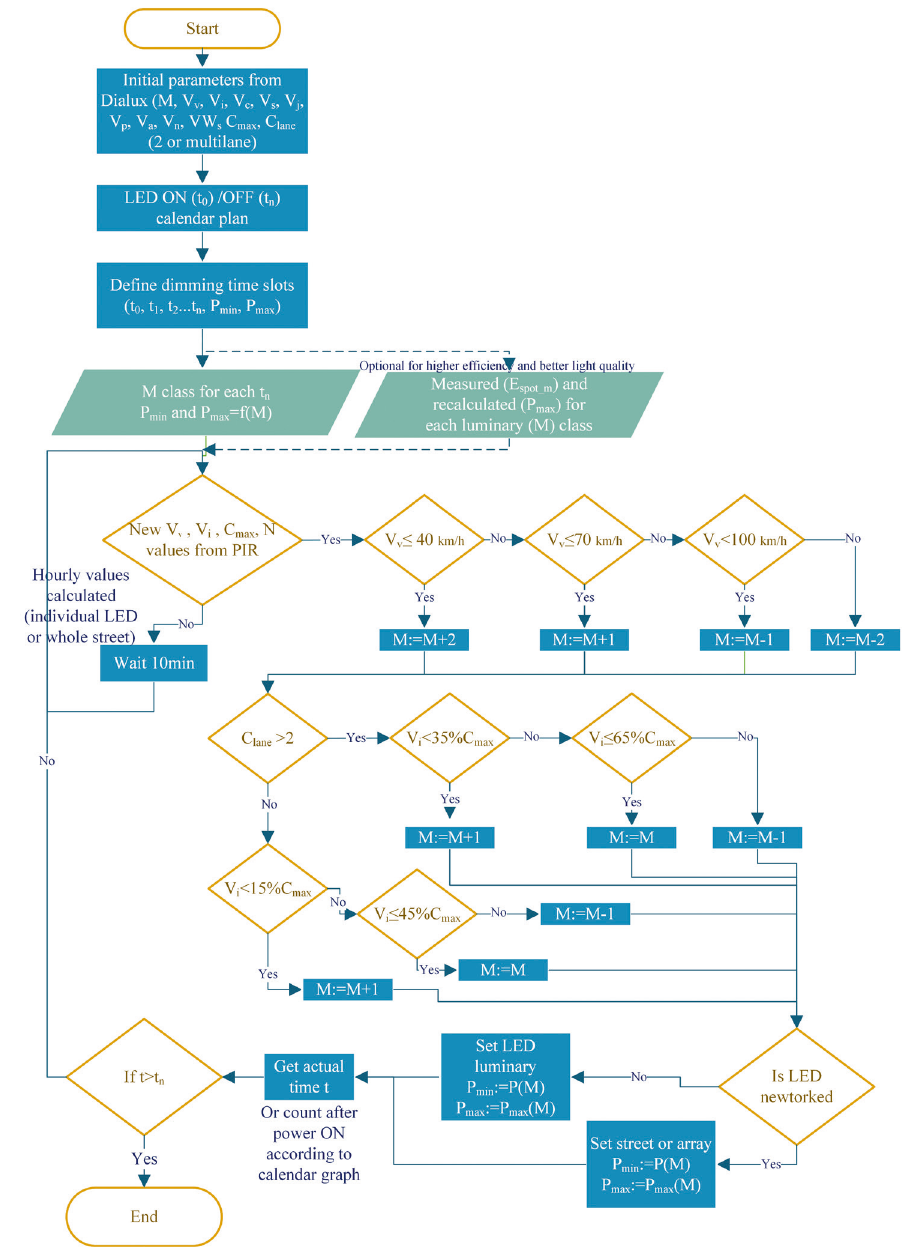
Figure 21. LED luminaire dynamic ME class control algorithm for the proposed sensor system (standalone or networked